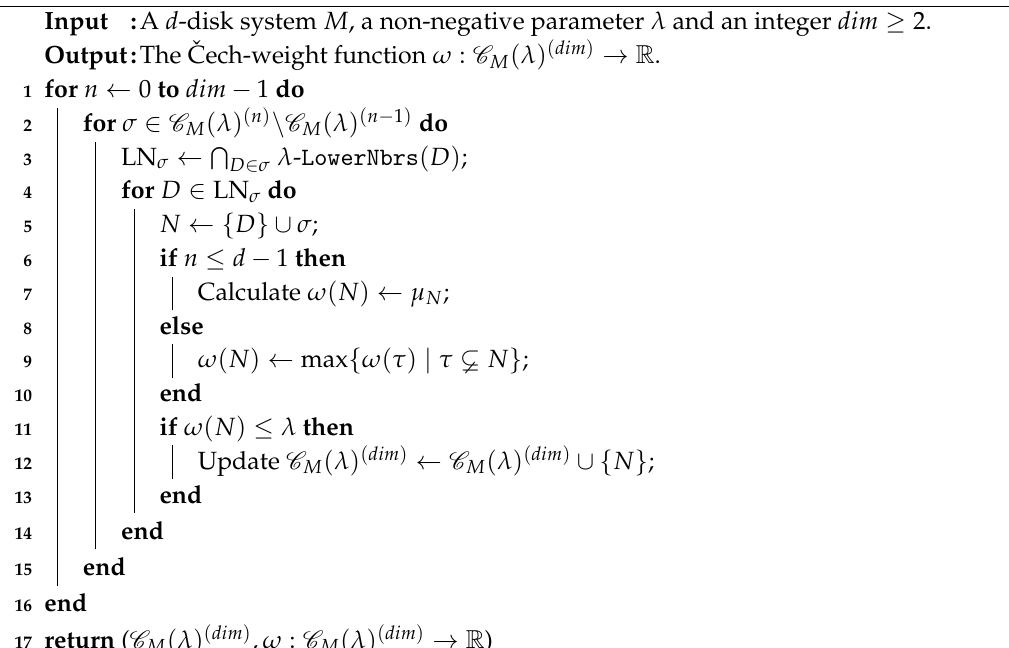
Algorithm 1: ˇCech-weight function of a d -disk system.